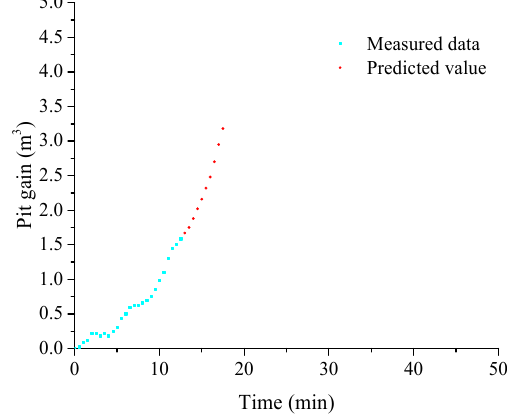
Figure 6. Measured data and predicted values of pit gain vs. time.